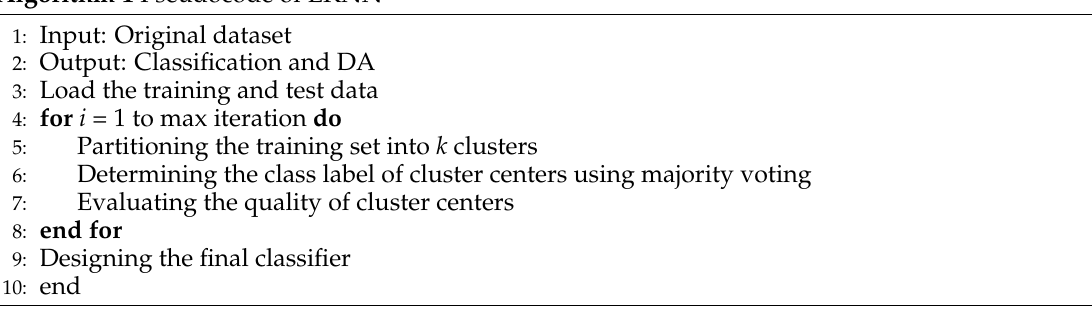
Algorithm 1 Pseudocode of